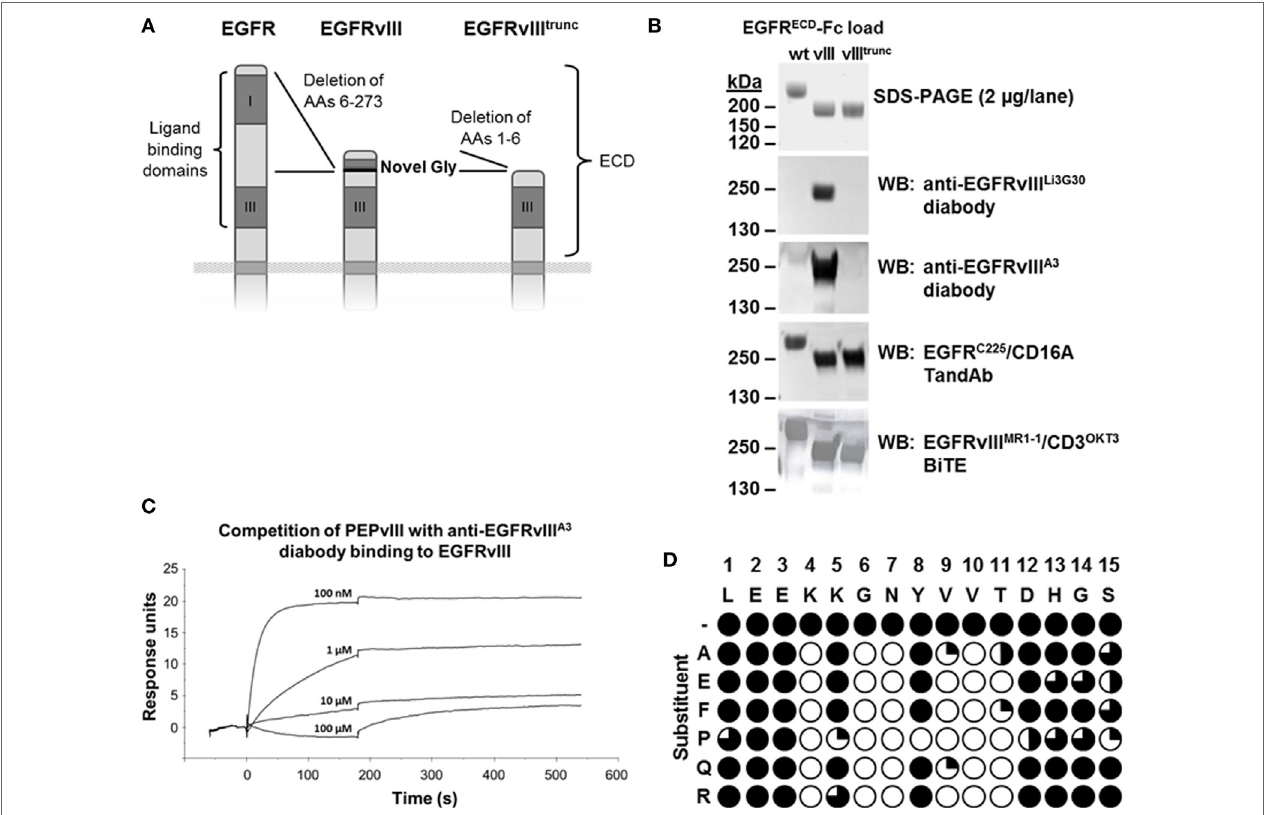
FigUre 2 | Binding specificity for egFrviii antigen . (a) Scheme of the extracellular domains (ECD) of EGFR, EGFRvIII, and a further truncated EGFRvIII variant EGFRvIII trunc (recombinant, not naturally occurring). (B) Binding of different EGFRvIII- or EGFR-targeting antibodies or antibody fragments to recombinant Fc-fusions of these ECD variants after non-reducing SDS-PAGE and Western Blot. EGFRvIII ECD due to the 267 amino acid deletion has an ~25 kDa smaller molecular size than EGFR ECD , resulting in an ~50 kDa size difference in the dimeric form of the Fc-fusion proteins under non-reducing conditions. (c) Binding of the anti-EGFRvIII A3 diabody to immobilized EGFRvIII antigen is efficiently outcompeted with increasing concentrations of EGFRvIII-specific peptide PEPvIII (aa-sequence: LEEKKGNYVVTDH). (D) Normalized ELISA signals for binding of anti-EGFRvIII A3 diabody to EGFRvIII N-terminal epitope spanning 15-mer peptides containing single amino acid substitutions in each position of the native sequence. Filled circles indicate strong binding to the native sequence or correspondingly substituted sequences, open circles indicate positions in which substitutions completely disrupted